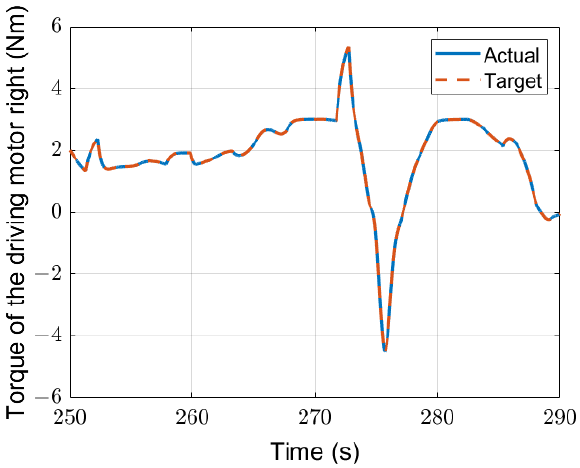
Figure 15. Torque of driving actuator right (blue line: the actual driving torque; red dotted line: the ideal driving torque).